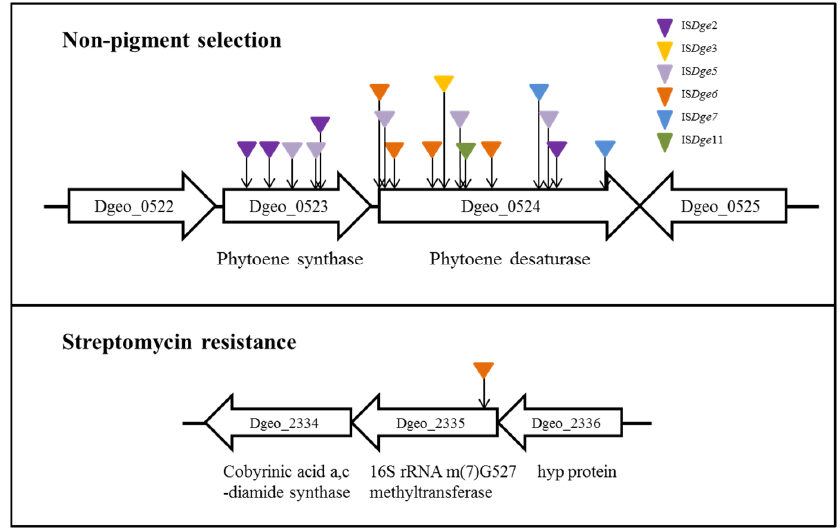
Figure 2. Active transposition of IS elements in Deinococcus geothermalis under oxidative stress. The transposition events were isolated from two phenotypic selections.